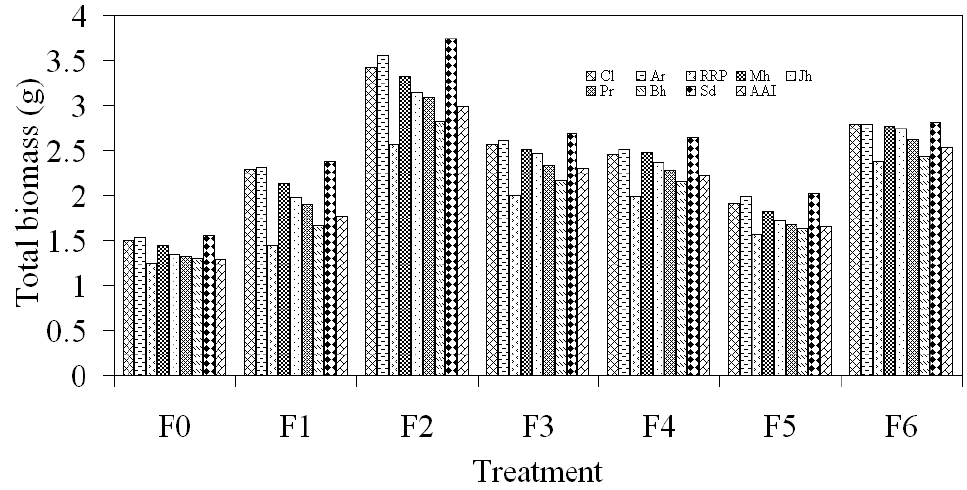
FIGURE 2. Effect of different fertility levels on total biomass of wheat plants grown at various